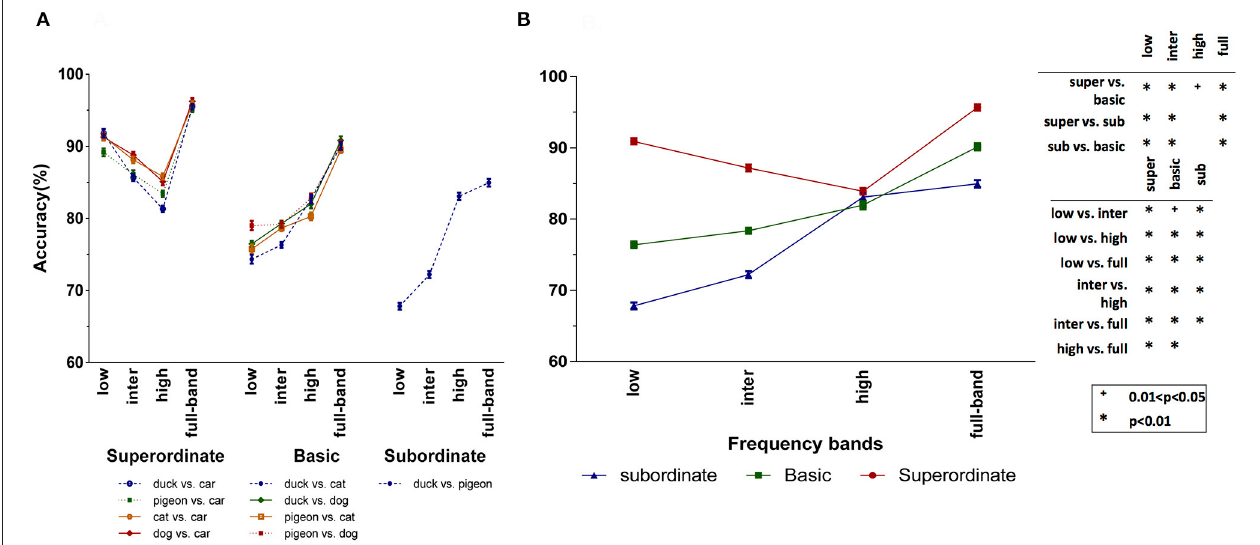
FIGURE 6 | Mean accuracies of Model I (averaged over 10 independent runs) for different categorization levels and spatial frequency bands. (A) Model’s accuracy for the different tasks of each categorization level. (B) Average accuracies over the different tasks of the superordinate (duck vs. car, pigeon vs. car, cat vs. car, and dog vs. car), basic (duck vs. cat, duck vs. dog, pigeon vs. cat, and pigeon vs. dog) and subordinate (duck vs. pigeon) levels. The p -value matrix presents the significant and strongly significant values using + and * signs, respectively. Error bars represent standard error of the mean (SEM). The between (within) group df is 11